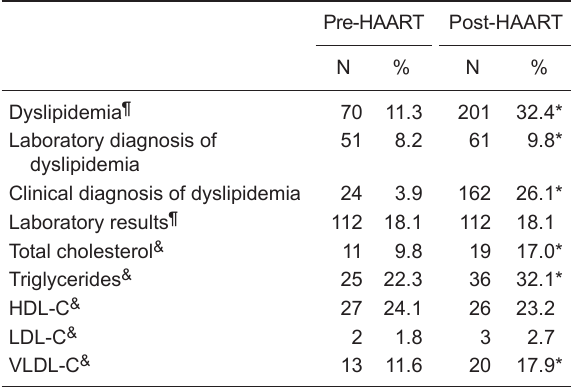
Table 1. Laboratory and clinical characteristics of the participants according to dyslipidemia diagnosis, Belo Horizonte, 2009.